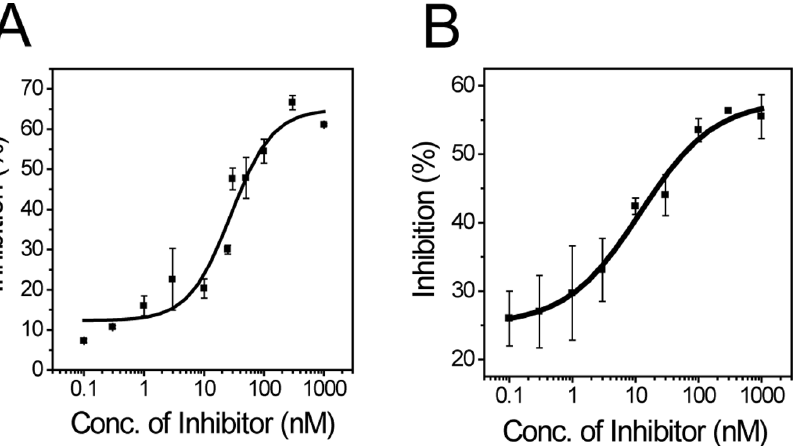
Figure 6. Inhibition of HCV NS3 protease by a known inhibitor. The cleavage of type I MBR ( A ) and type II MBR ( B ) by HCV NS3 protease was monitored in the presence of a known peptide derivative inhibitor, Ac-Asp-D-Gla-Leu-Ile- b -cyclohexyl-Ala-Cyc-OH. Both type I and type II MBRs exhibited significant dose-response at nanomolar concentrations.